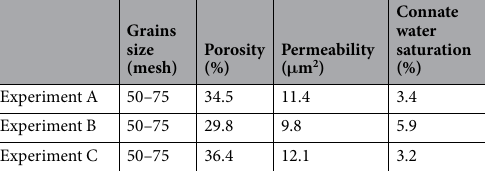
Table 1. The detailed parameters of sand packs in three experiments.